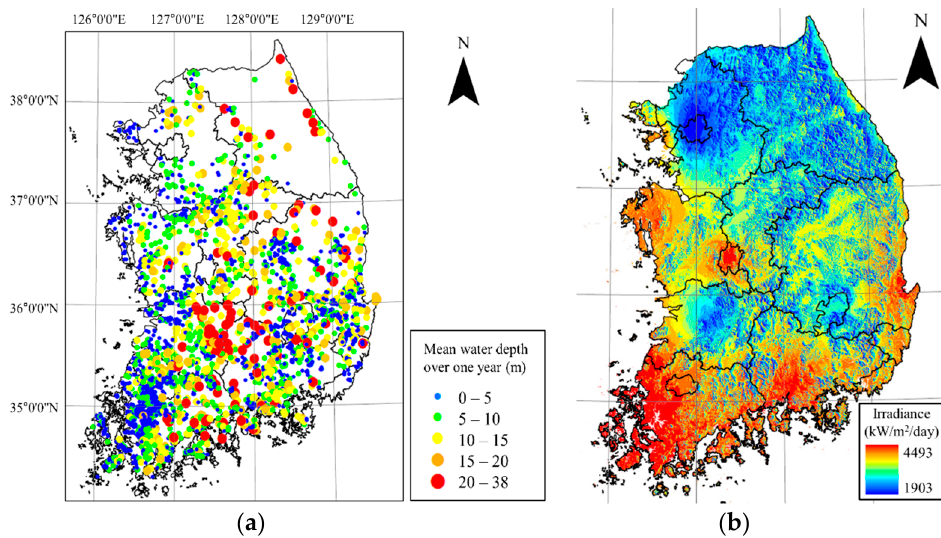
Figure 6. Floating PV analysis for reservoirs in Korea using a GIS: ( a ) Map of average water depth for each reservoir; ( b ) Solar radiance map considering terrain (Kim et al. [55]).